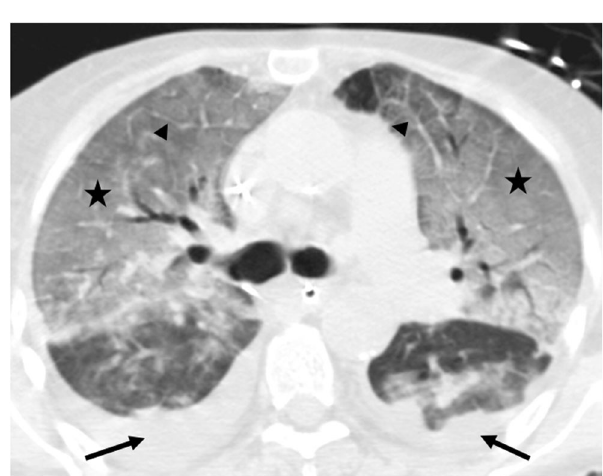
Fig. 13 Acute fibrinoid allograft pneumonia (AFOP). Acute shortness of breath. Intralobular septal thickening and extensive ground-glass opacities ( stars ), interlobular thickening ( arrowheads ), and pleural effusions ( arrows ), confirmed by histology